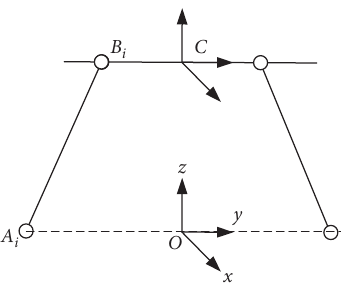
Figure 3: Simplified diagram of the mechanism in the parallel